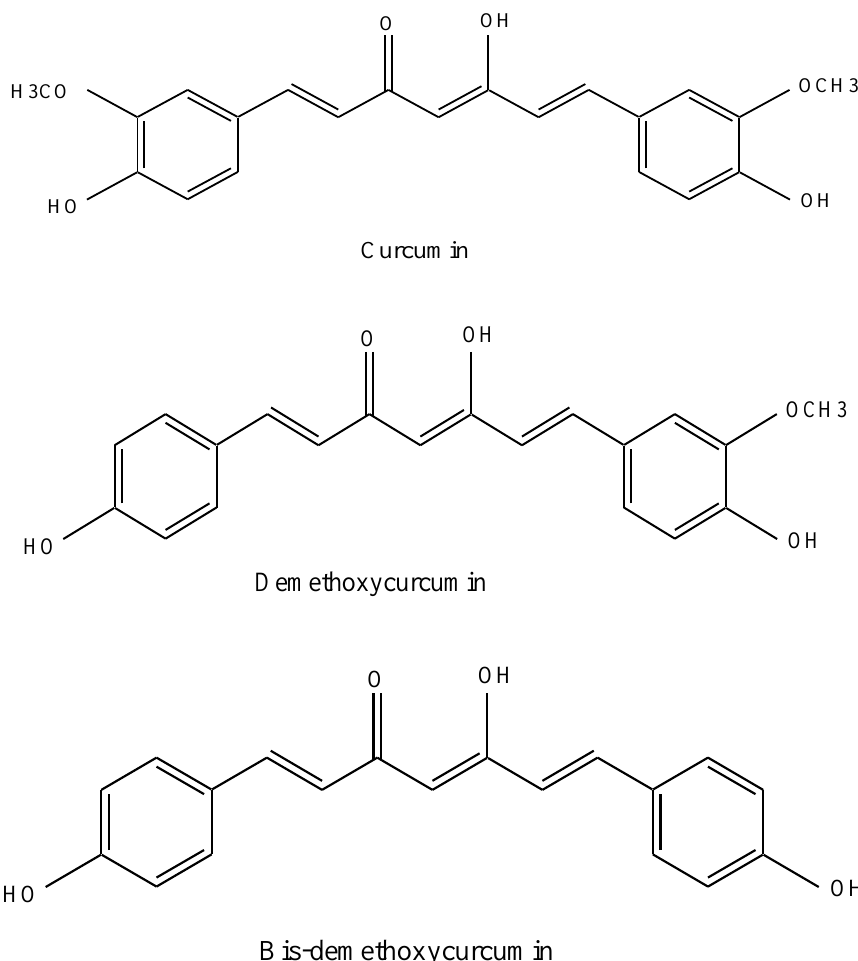
Figure 1. Structures of curcumin, demethoxycurcumin and bis-demethoxycurcumin.